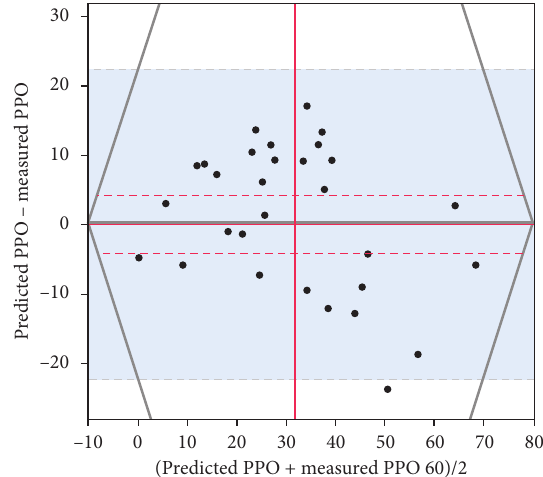
Figure 5: Method comparison—Bland–Altman plot: (a) Bland–Altman plot: the differences between PPO predicted and PPO measured vs. the mean value of both measurements. Dashed grey lines indicate the limit of agreement (0 ± 1.96 SD of differ- ence), the solid black line is the line of equality, the solid red line shows the mean difference (bias), and the dashed red lines show the 95% CI around the mean difference.